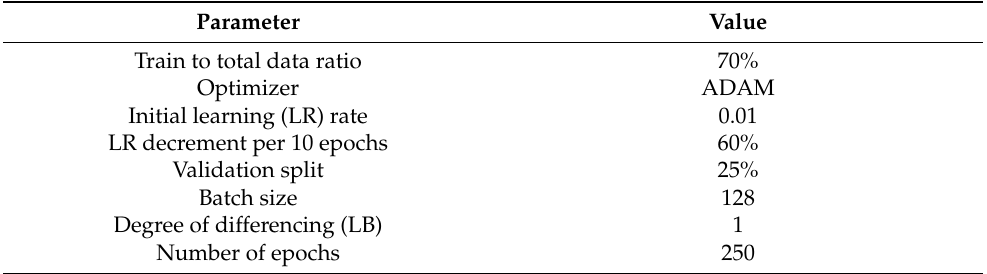
Table 4. Tuned hypermeters and model inputs for the parameter prediction in days span with LSTM.